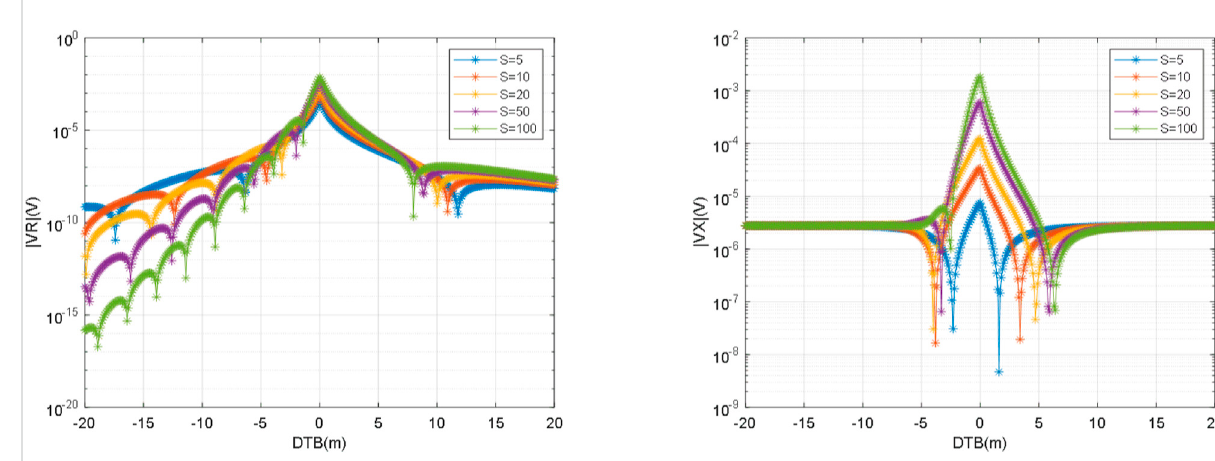
FIGURE 6 Response of the orthogonal receiver in different contrast stratum models.